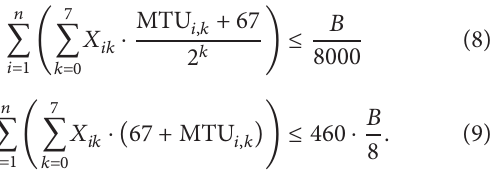
Table 1: {( 1, 5 ) , ( 2, 12 )} and {( 2, 9 ) , ( 1, 6 )} under the